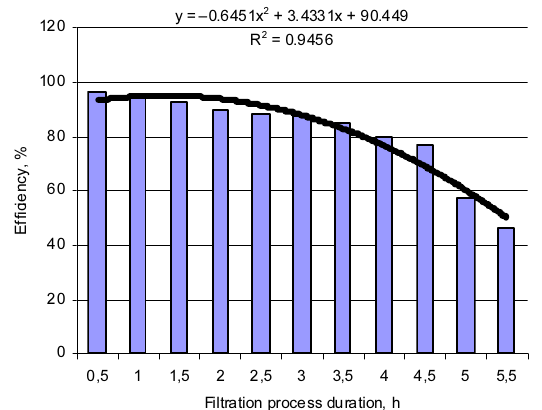
Fig. 3. Decrease of ammonium removal efficiency depending on filtration